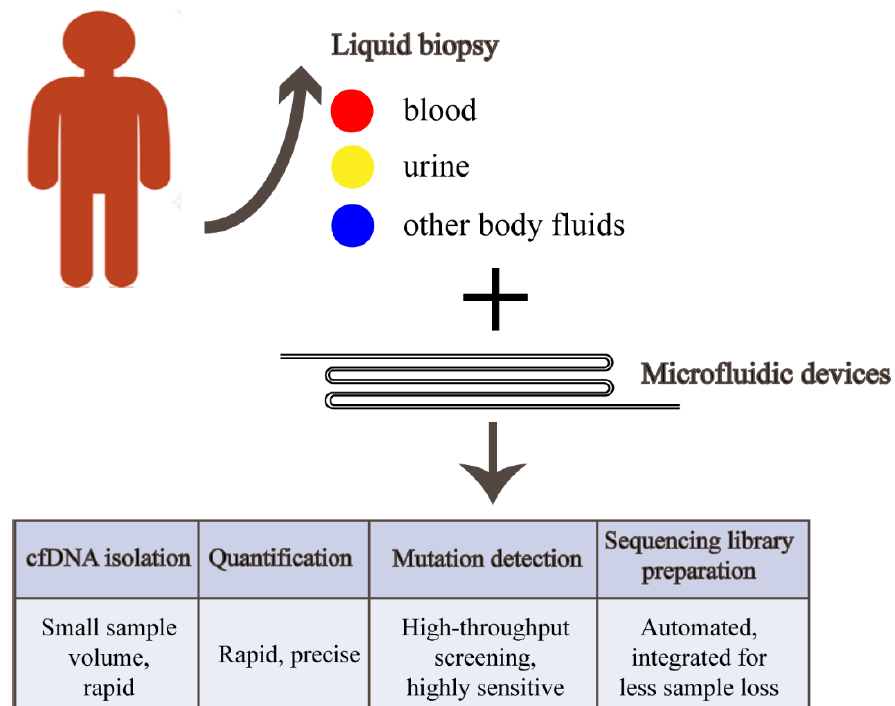
Figure 1. Main advantages that microfluidic devices can bring towards liquid biopsy. cfDNA can be isolated from blood, urine and other body fluids for quantification, mutation detection and next-generation sequencing using microfluidic ways.